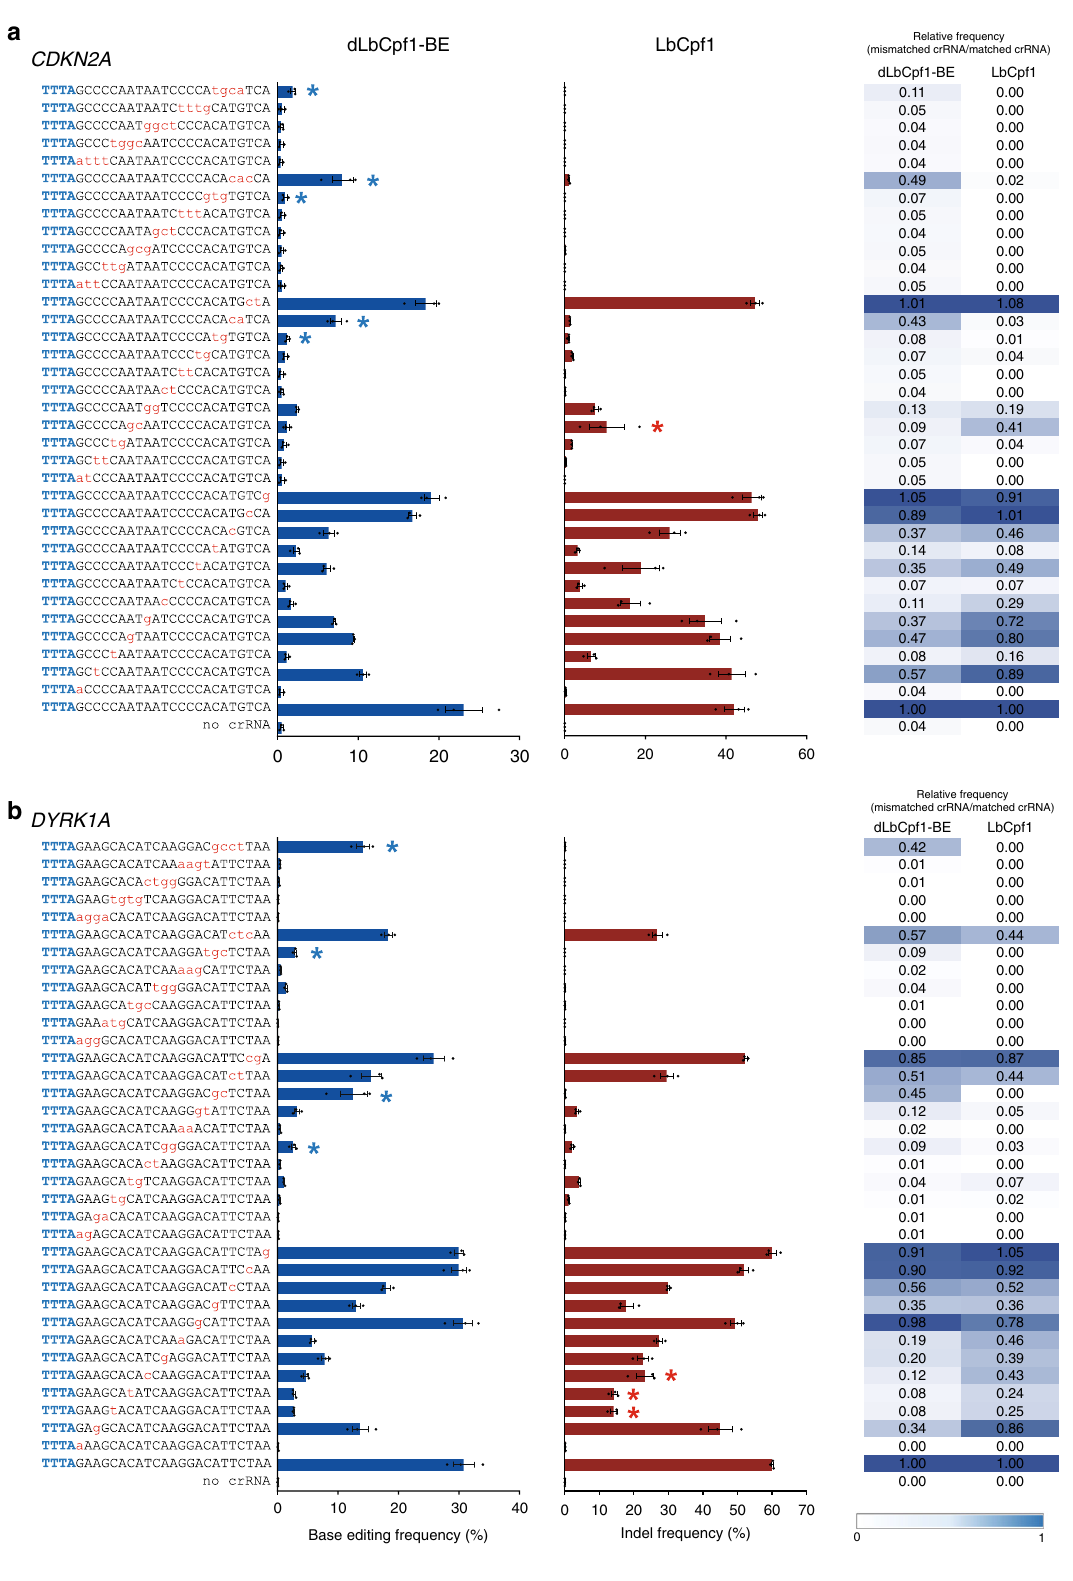
5 ′ -TNTN-3 ′ , or 5 ′ -TTNN-3 ′ ) and had 7 or fewer mismatches with the target sequence (Fig. 2d). Note that the mismatches at positions 21 – 23 in the protospacer had little effect on editing ef fi ciency (Fig. 1; Supplementary Fig. 2), so we used a 20-nt protospacer sequence to count the number of mismatches by comparing it with SSB sites and on-target sequence. We chose